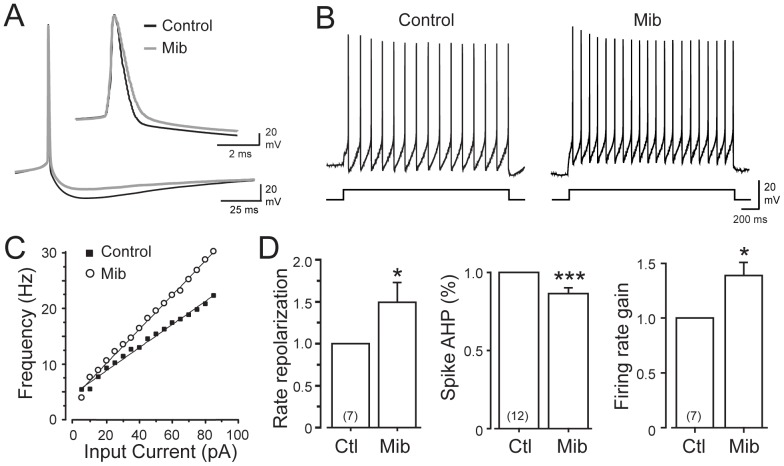
Cav3 calcium activation of KCa1.1 modulates repolarizing responses and gain of spike firing.
A, Representative superimposed recordings of spike discharge before and after perfusion of 1 µM mibefradil (Mib) to block the Cav3-KCa1.1 interaction. Mibefradil slows that rate of repolarization (inset) and reduces the AHP. B, Representative examples of spike firing during square wave current pulse injections before and after 1 µM mibefradil showing an increase in the rate of firing. C, Current-frequency plot for the cell in (B) reveals an increase in the gain of firing frequency in mibefradil. D, Bar plots of the mean rate of spike repolarization, AHP amplitude, and firing rate gain on current-frequency plots before and after mibefradil. Membrane potential was set through bias current injection to ∼−74 mV to subdue baseline tonic firing of MVN cells and spike properties were measured near threshold firing level evoked by square wave current injections. Sample sizes are shown in brackets in (D).